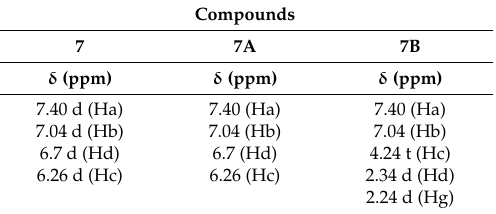
Table 2. 1 H-NMR data of compound 7 and its biotransformation products ( 7A and 7B